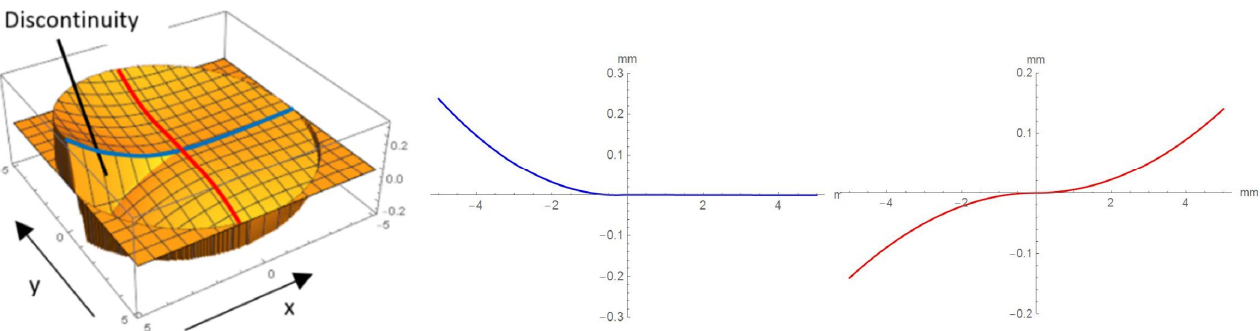
Figure 3. Left: Superelevated geometry of a lens surface with lines of intersection parallel to the x-axis (blue) and parallel to the y-axis (red). Middle: Profile parallel to x-axis along the blue intersection path. For positive abscissae, the ordinates are zero and the curve directly superimposes the x-axis. Right: Profile parallel to y-axis along the red intersection path [21].